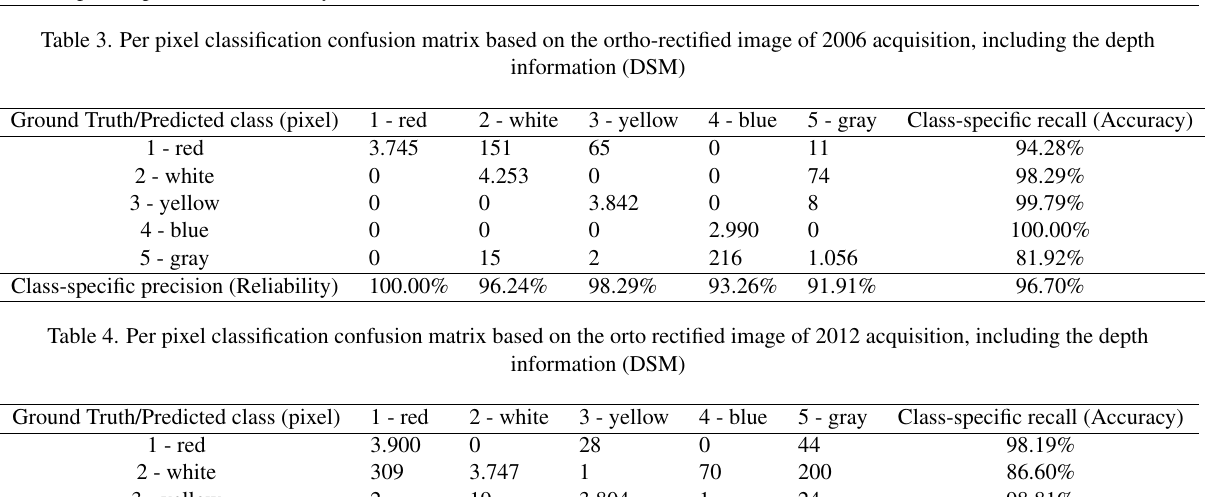
Class-specific precision (Reliability) Table 3. Per pixel classification confusion matrix based on the ortho-rectified image of 2006 acquisition, including the depth